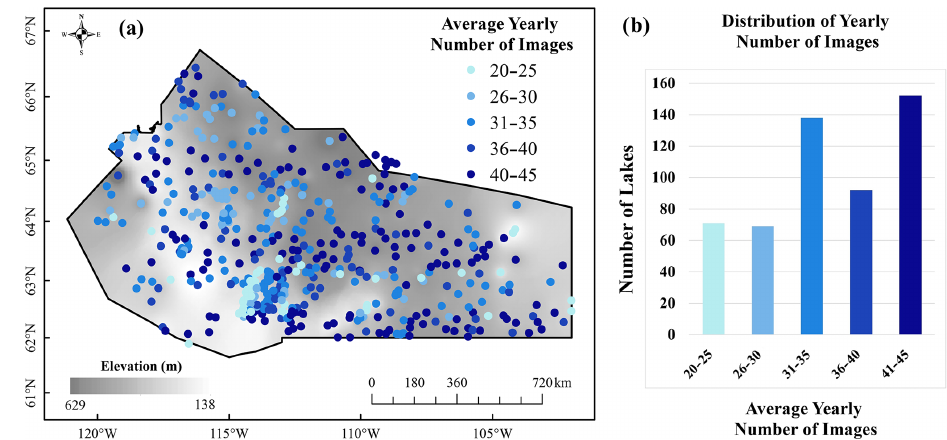
Figure 9. Distribution of the average yearly number of available images for lakes in the